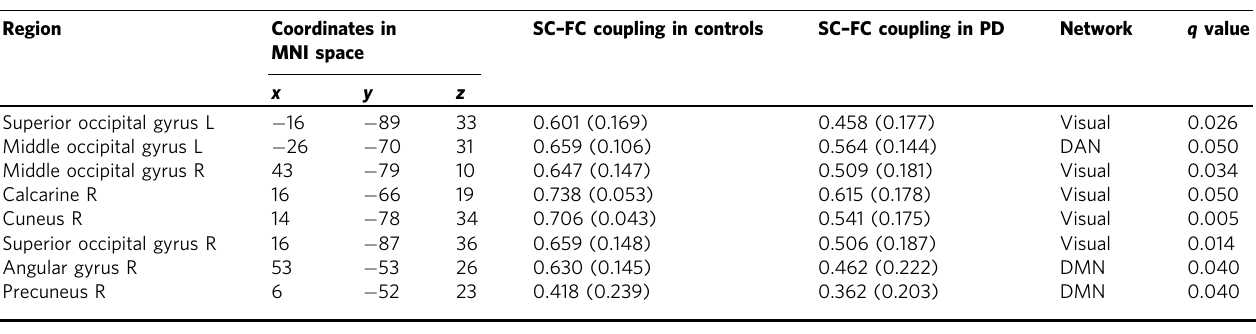
Table 2 Nodes showing structural – functional connectivity decoupling in PD compared with controls and in PD low vs high visual